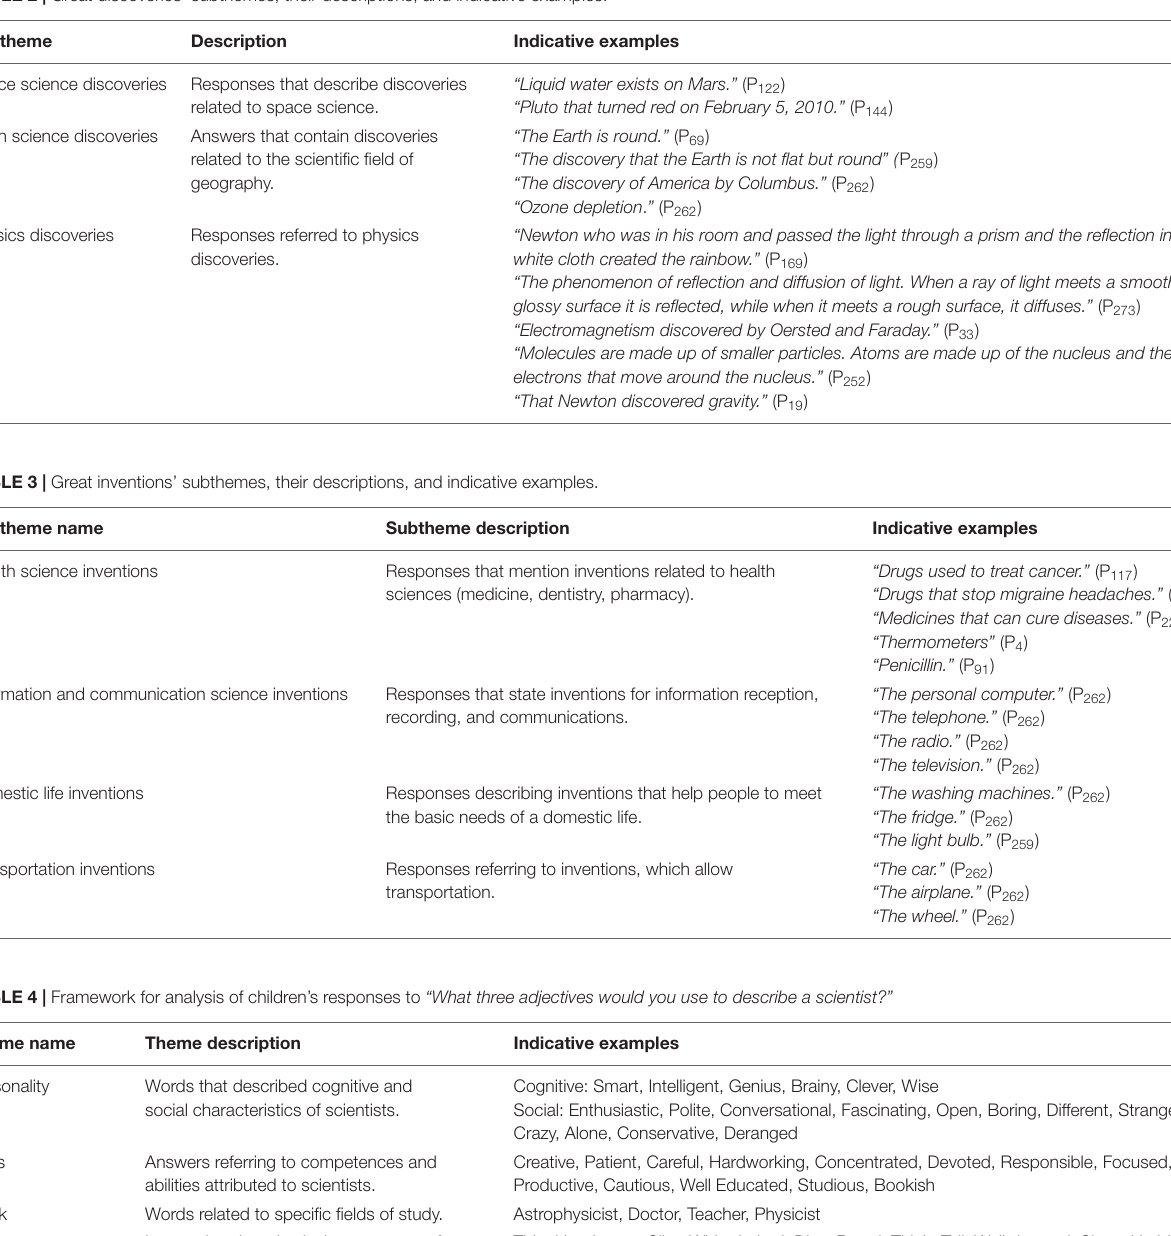
TABLE 2 | Great discoveries’ subthemes, their descriptions, and indicative examples.